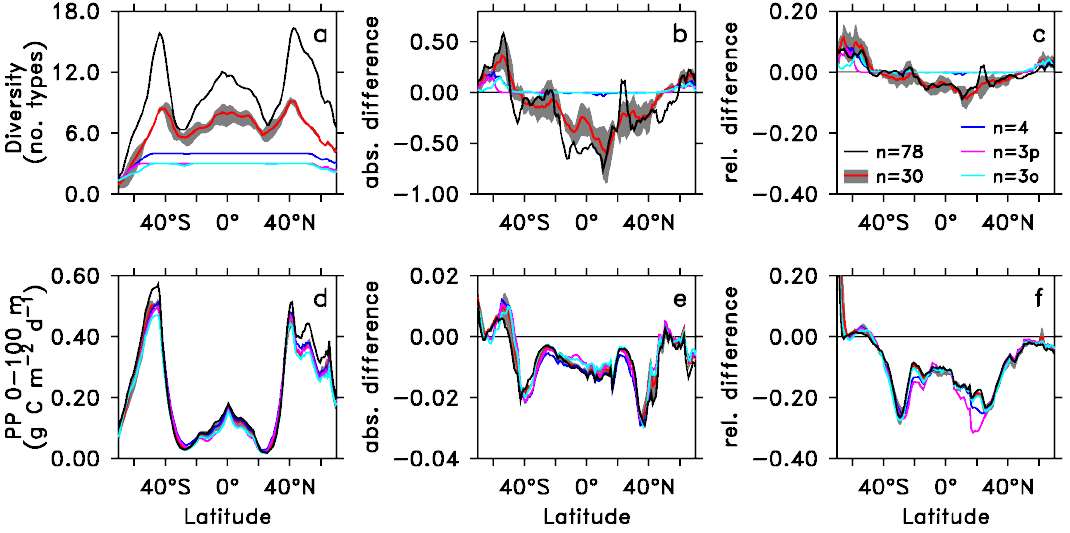
Figure 2. Zonal averages of diversity as number of subtypes exceeding threshold biomass P th (a – c ), and of primary production (PP; d–f ) in the simulations without reduction in mixing (a, d) , and as absolute (b, e) and relative (c, f) difference between scenarios with and without reduced mixing 10yr after mixing reduction. Results are shown for one simulation with n = 78 phytoplankton subtypes, the average of three simulations using different subpopulations of the n = 78 simulation with n = 30 subtypes with minimum and maximum values indicated by the grey shaded area, and three simulations with all four generic phytoplankton functional types ( n = 4), and with three PFTs omitting the Prochlorococcus and the other-small PFT ( n = 3 p and n = 3 o , respectively). See panel (c) for colour code.